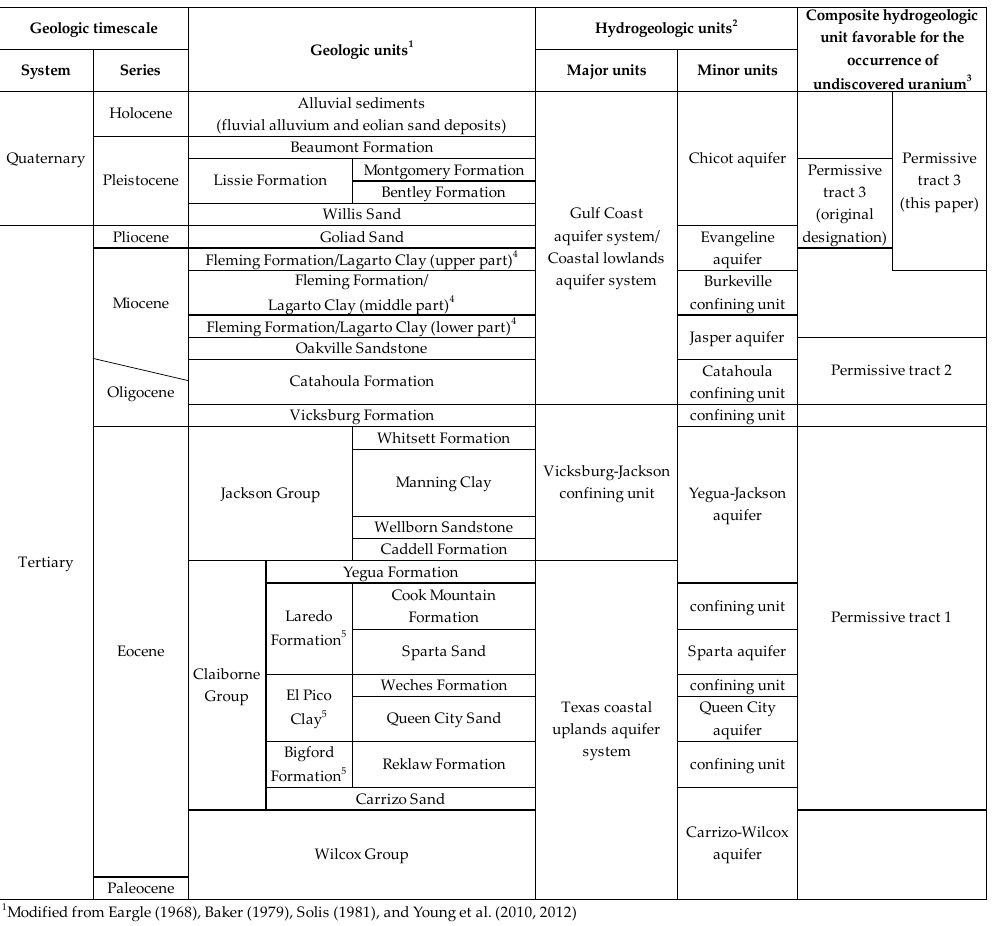
Figure 2. Geologic and hydrogeologic units of the Texas Coastal Plain and the three geologic regions, or tracts, that have favorable characteristics for the occurrence of undiscovered uranium resources, or permissive tracts, as delineated by [1]. Geologic units are modified from [5–9]. Hydrogeologic units are modified from [5,6,10,11]. Permissive tracts are modified from [1]. The Fleming Formation and Lagarto Clay are considered equivalent throughout the study area [9]. The Bigford Formation, El Pico Clay, and Laredo Formation are geologic units of the Rio Grande